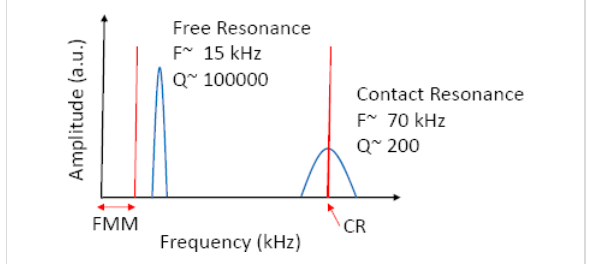
Figure 2: Schematic of the non-contact/free resonance and contact resonance frequencies of the AFM cantilever used in all experiments (blue lines). Typical frequencies and Q-factors that are measured both in non-contact ( f = 15 kHz, Q = 100,000) and in contact mode ( f = 70 kHz, Q = 200) are shown on the graph. Excitation frequencies used in CF-AFM and FMM modes are shown with red lines. The FMM measurement has a range of excitation frequency which is smaller than the first free resonance of the cantilever and above 1 kHz.